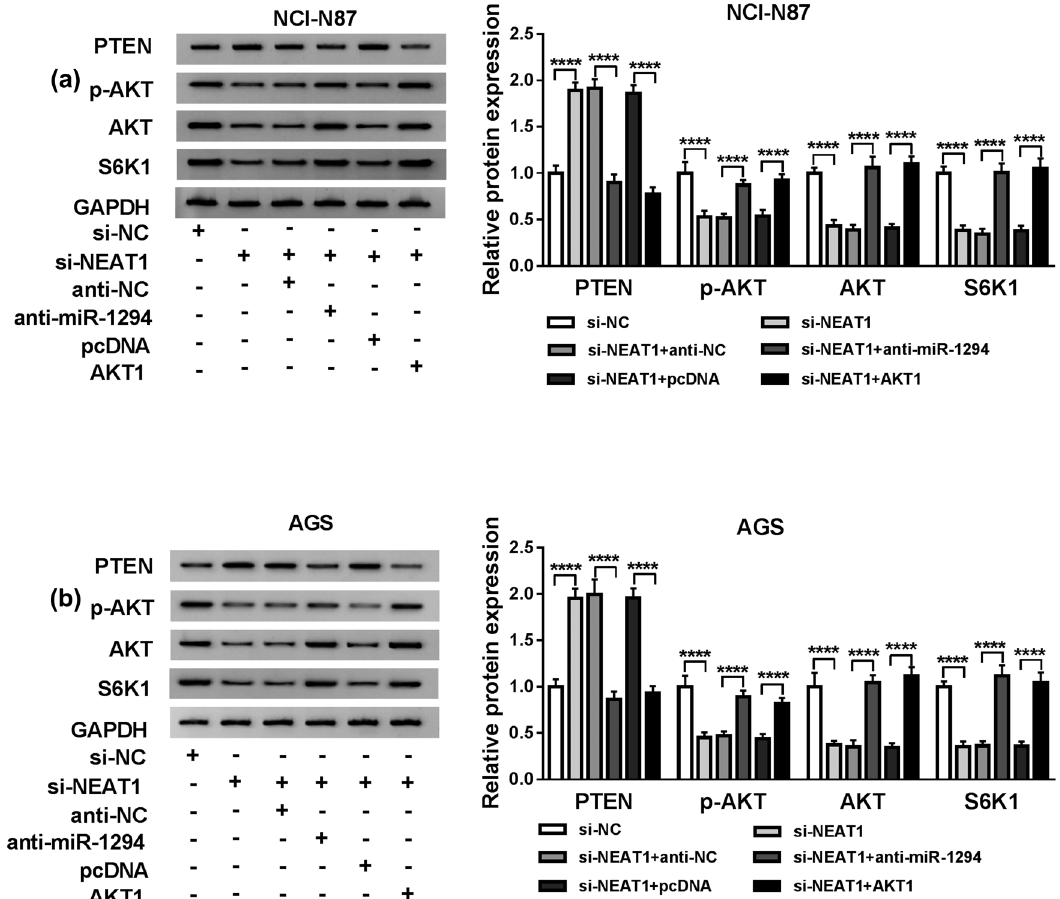
Figure 6: Down - regulation of NEAT1 repressed PI3K/AKT/mTOR signaling pathway via elevating miR - 1294 and decreasing AKT1. ( a and b ) Western blot was utilized to detect the expression levels of PTEN, p - AKT, AKT, and S6K1 in NCI - N87 cells co - transfected with si - NEAT1 + anti - miR - 1294 or si - NEAT1 + AKT1 ( a ) , as well as in AGS cells ( b ) . **** P <